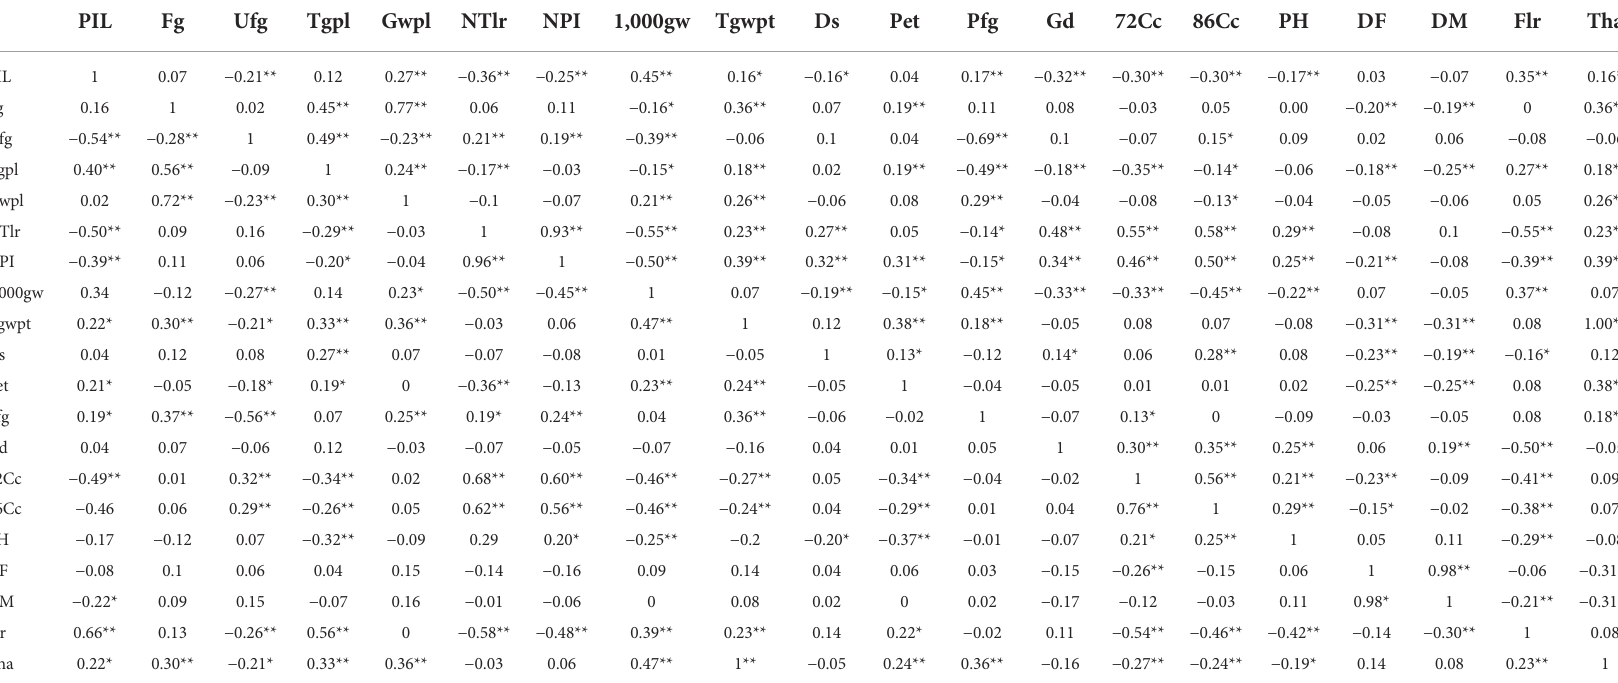
TABLE 8 Correlation between all traits for MR219 (below orthogonal matrix) and MR263 (above orthogonal matrix)